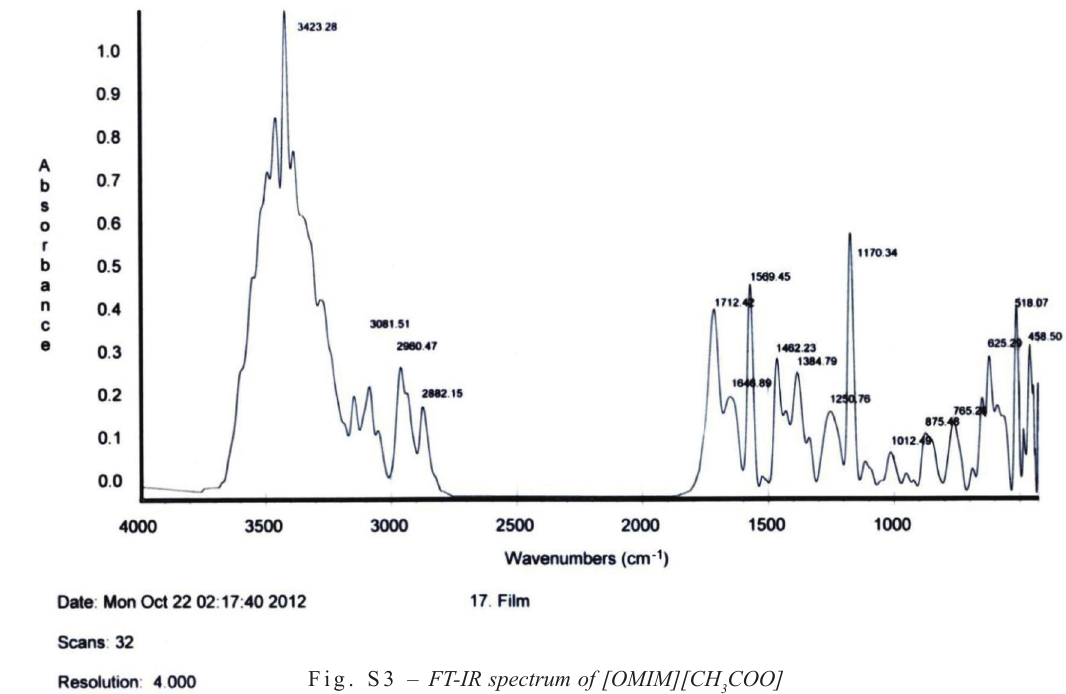
Fig. S3 – Ft­Ir spectrum of [OMIM][CH